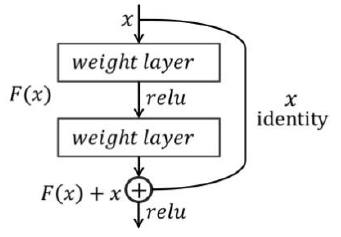
Figure 2. The residual block of a residual network (ResNet).